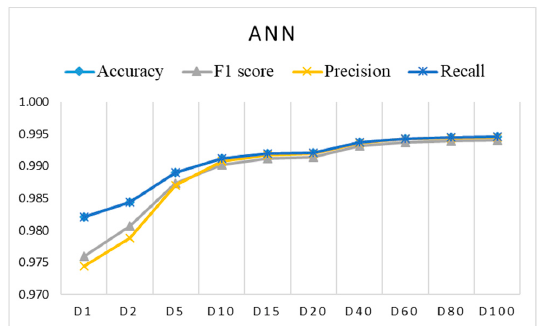
Figure 8. Evaluation results for imbalanced training datasets Di using ANN (coincidence of accuracy and recall).